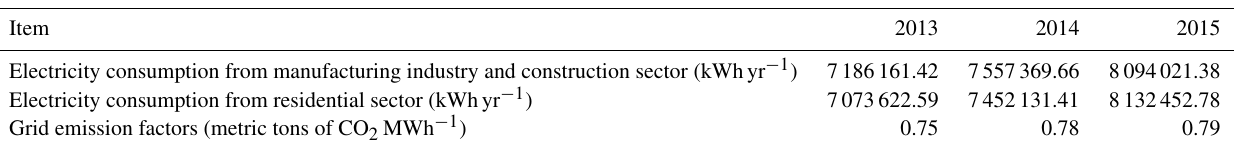
Table 9. Electricity consumption of manufacturing industry and construction and residential sectors and grid emission factors in HCMC (2013, 2014, 2015), provided by Electricity of Vietnam (EVN).